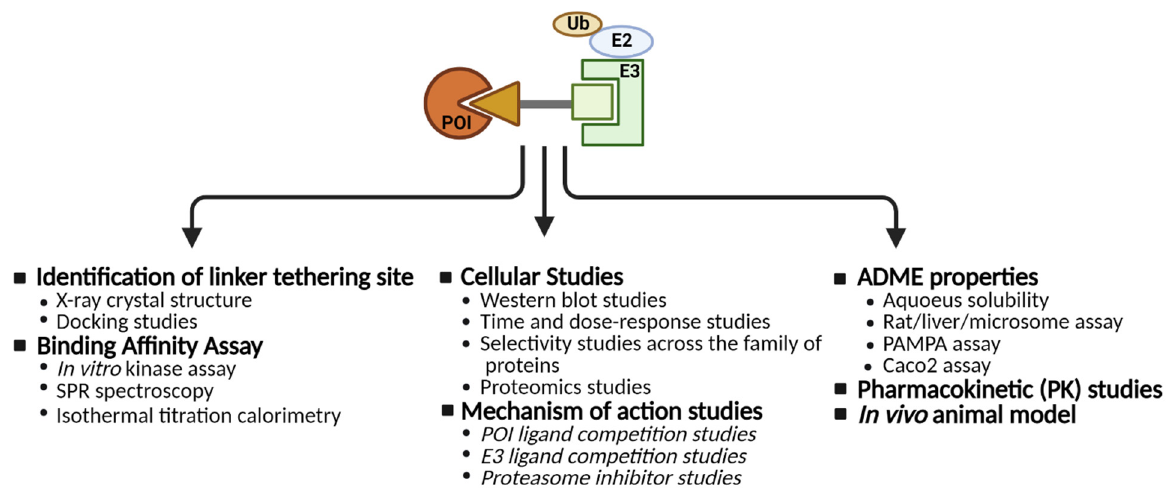
Figure 5. A flowchart highlighting the development of a PROTAC (created with BioRender.com).